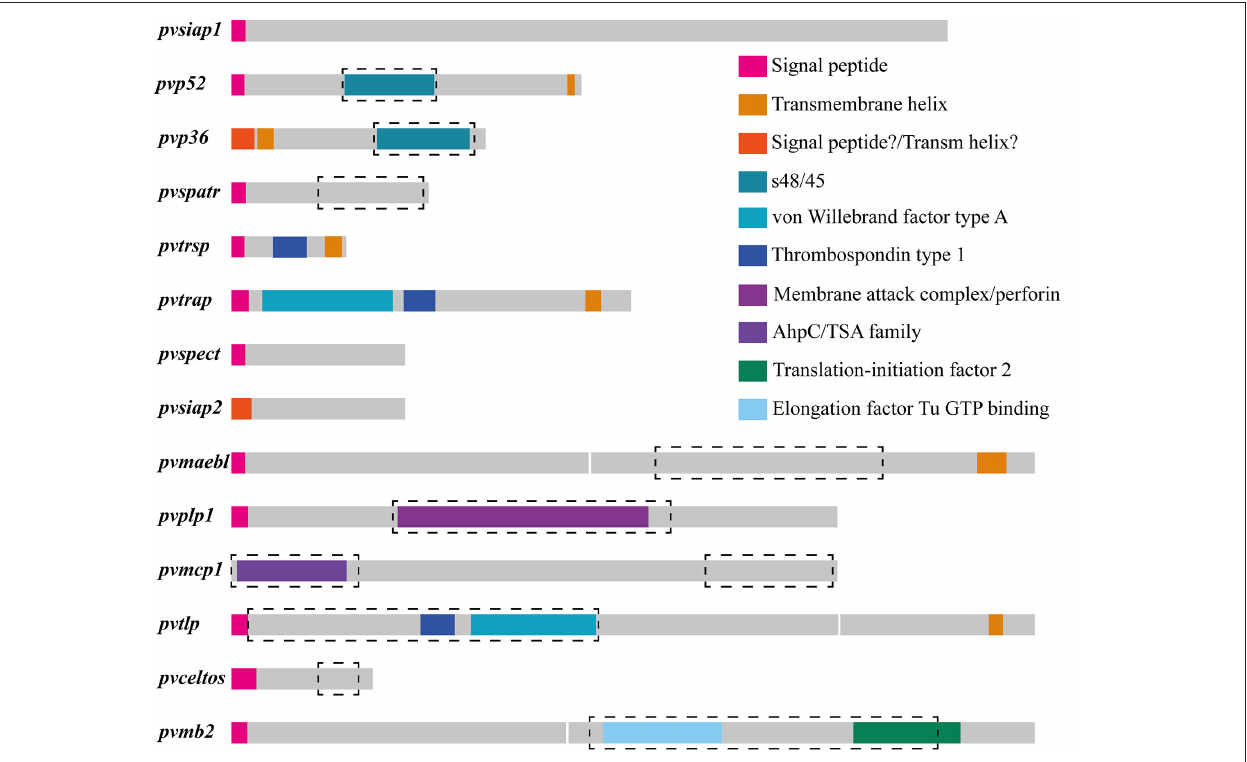
FIGURE 1 | Schematic models for Plasmodium vivax sporozoite antigen encoding genes and their predicted functionally constrained regions. The 14 putative P. vivax sporozoite antigens were characterized in silico . Each antigen’s predicted structure is shown in different colors and the predicted regions under functional constraint (highly conserved between species, having a ω < 1 and several negatively selected codons) are enclosed by a black dashed rectangle. In most cases, these regions correspond with regions having a putative domain. A region encoding a transmembrane helix was predicted for pvp36 and pvsiap2 at the 5 ′ -end, but this could have been a misleading prediction (i.e., it could actually have been a signal peptide).